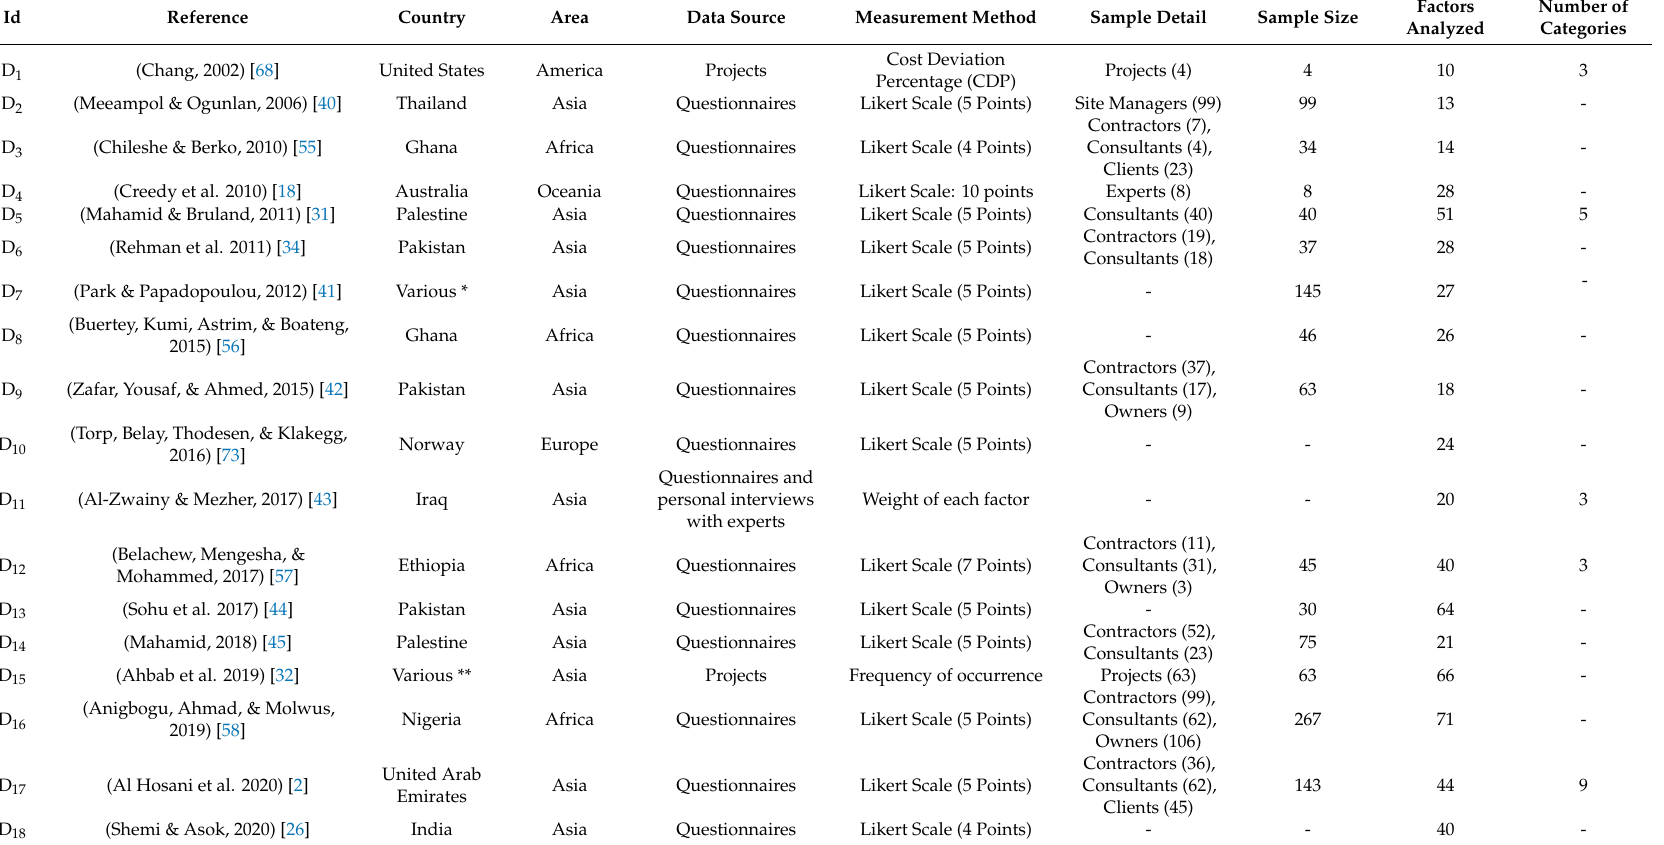
Table 3. Documents classified in the evidence